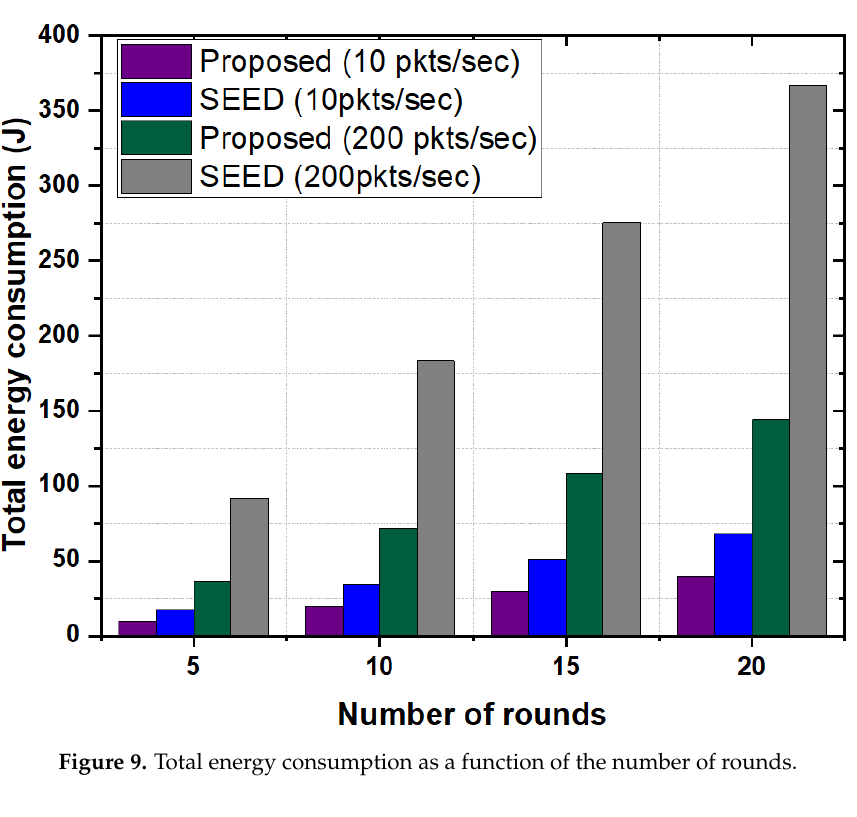
Figure 9. Total energy consumption as a function of the number of rounds.